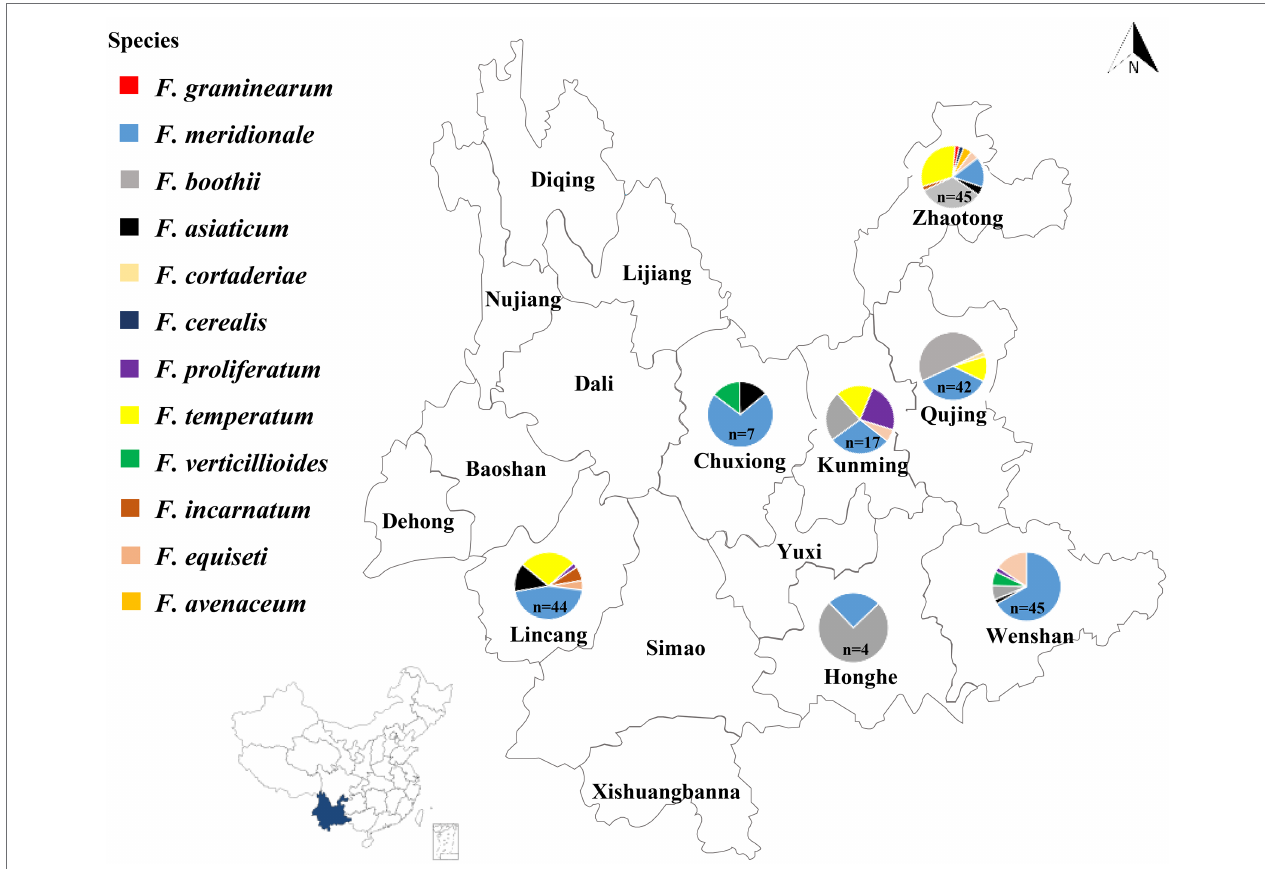
FIGURE 1 | Geographical distribution of Fusarium species isolated from maize stalks in Yunnan Province of China. The number of Fusarium isolates collected in each location was indicated by n : Wenshan ( n = 45), Honghe ( n = 4), Lincang ( n = 44), Chuxiong ( n = 7), Kunming ( n = 17), Qujing ( n = 42), and Zhaotong ( n =